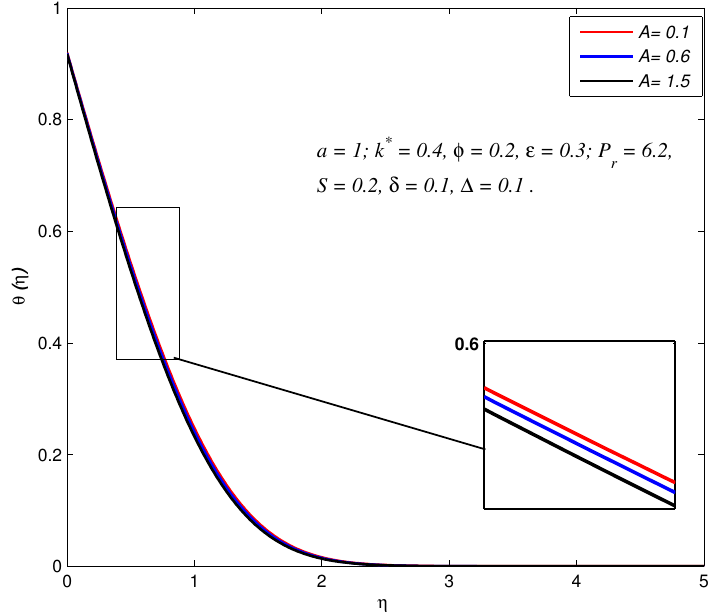
Figure 8. Temperature θ ( η ) profiles for different values of viscosity parameter A